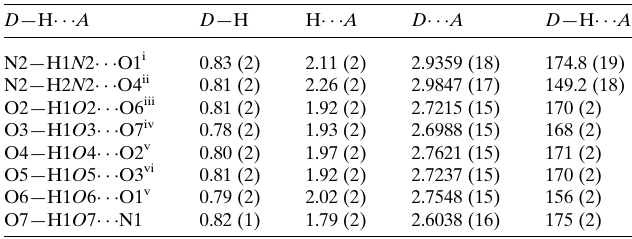
Table 2 Hydrogen-bond geometry (A˚ , (cid:4) ).